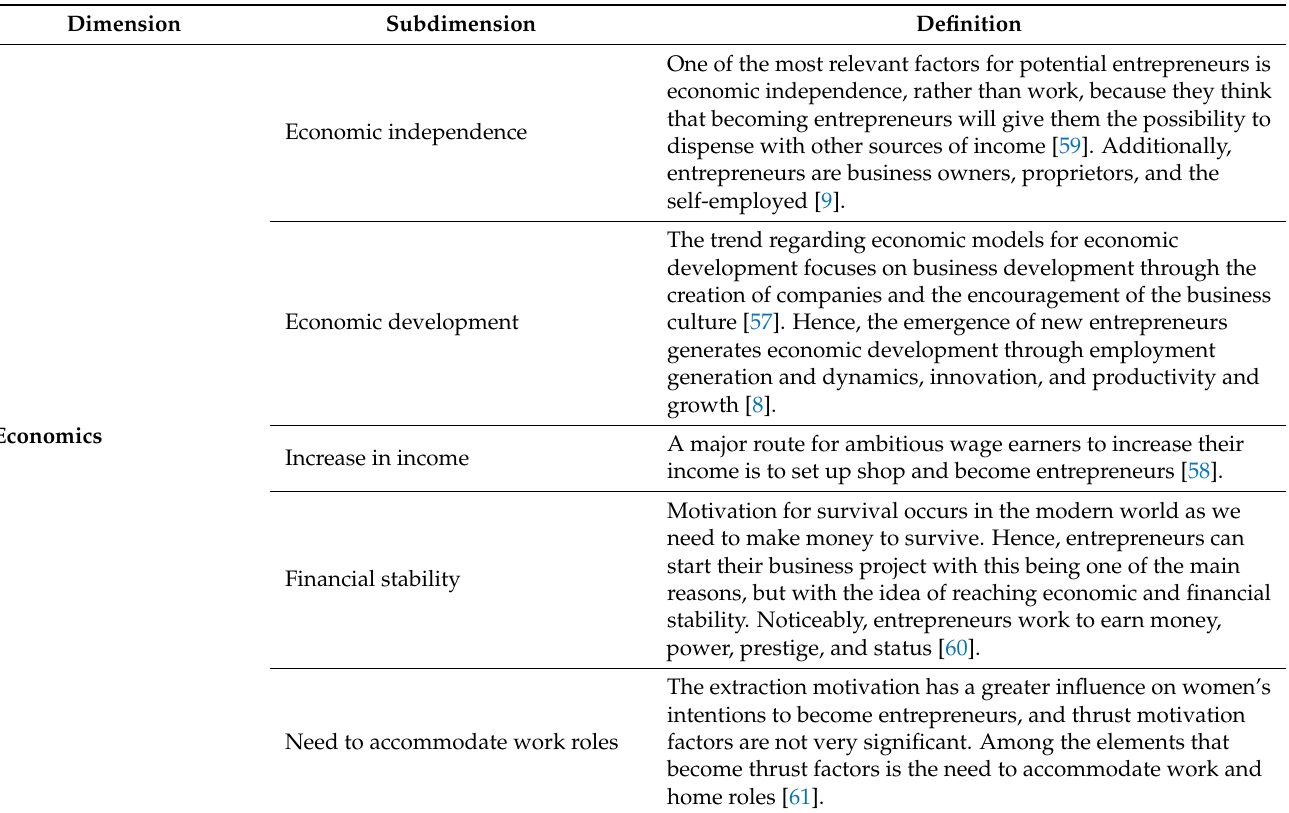
Table 1. The economic